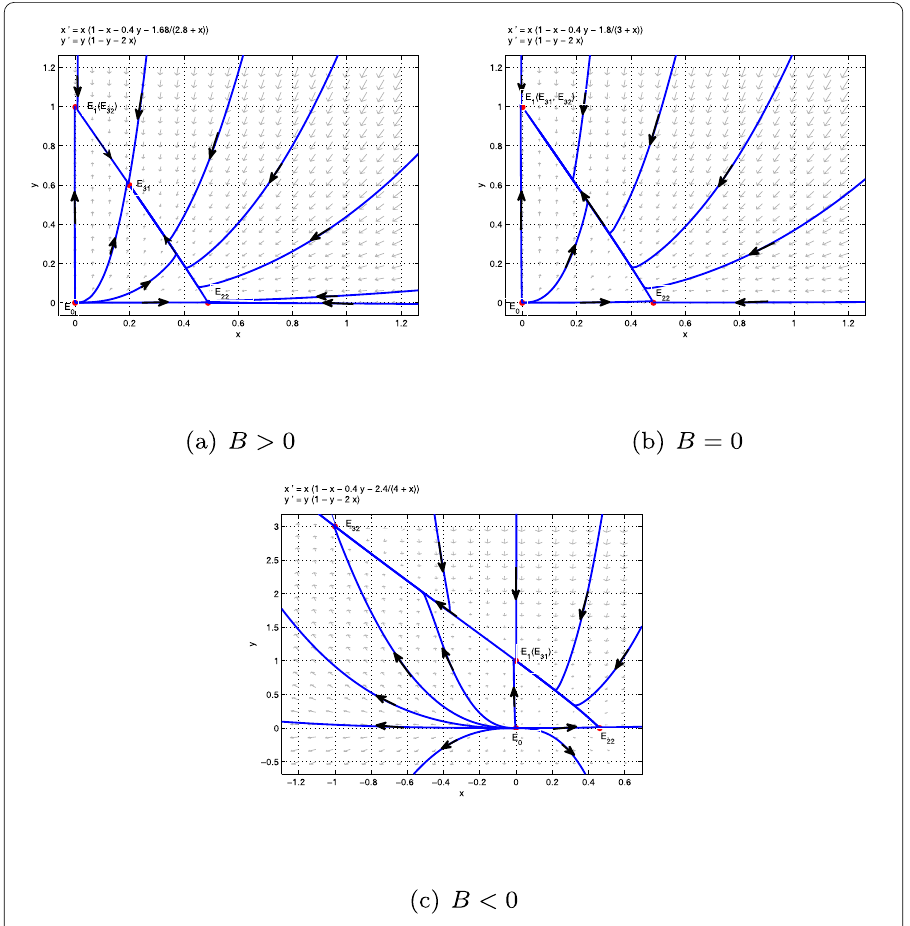
Figure 9 The phase portraits of transcritical bifurcation of system (1.6) around E